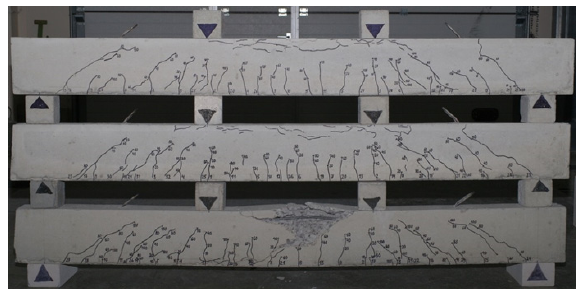
Fig. 13. Marked cracks on the S7, S8, and S9 beams (from the